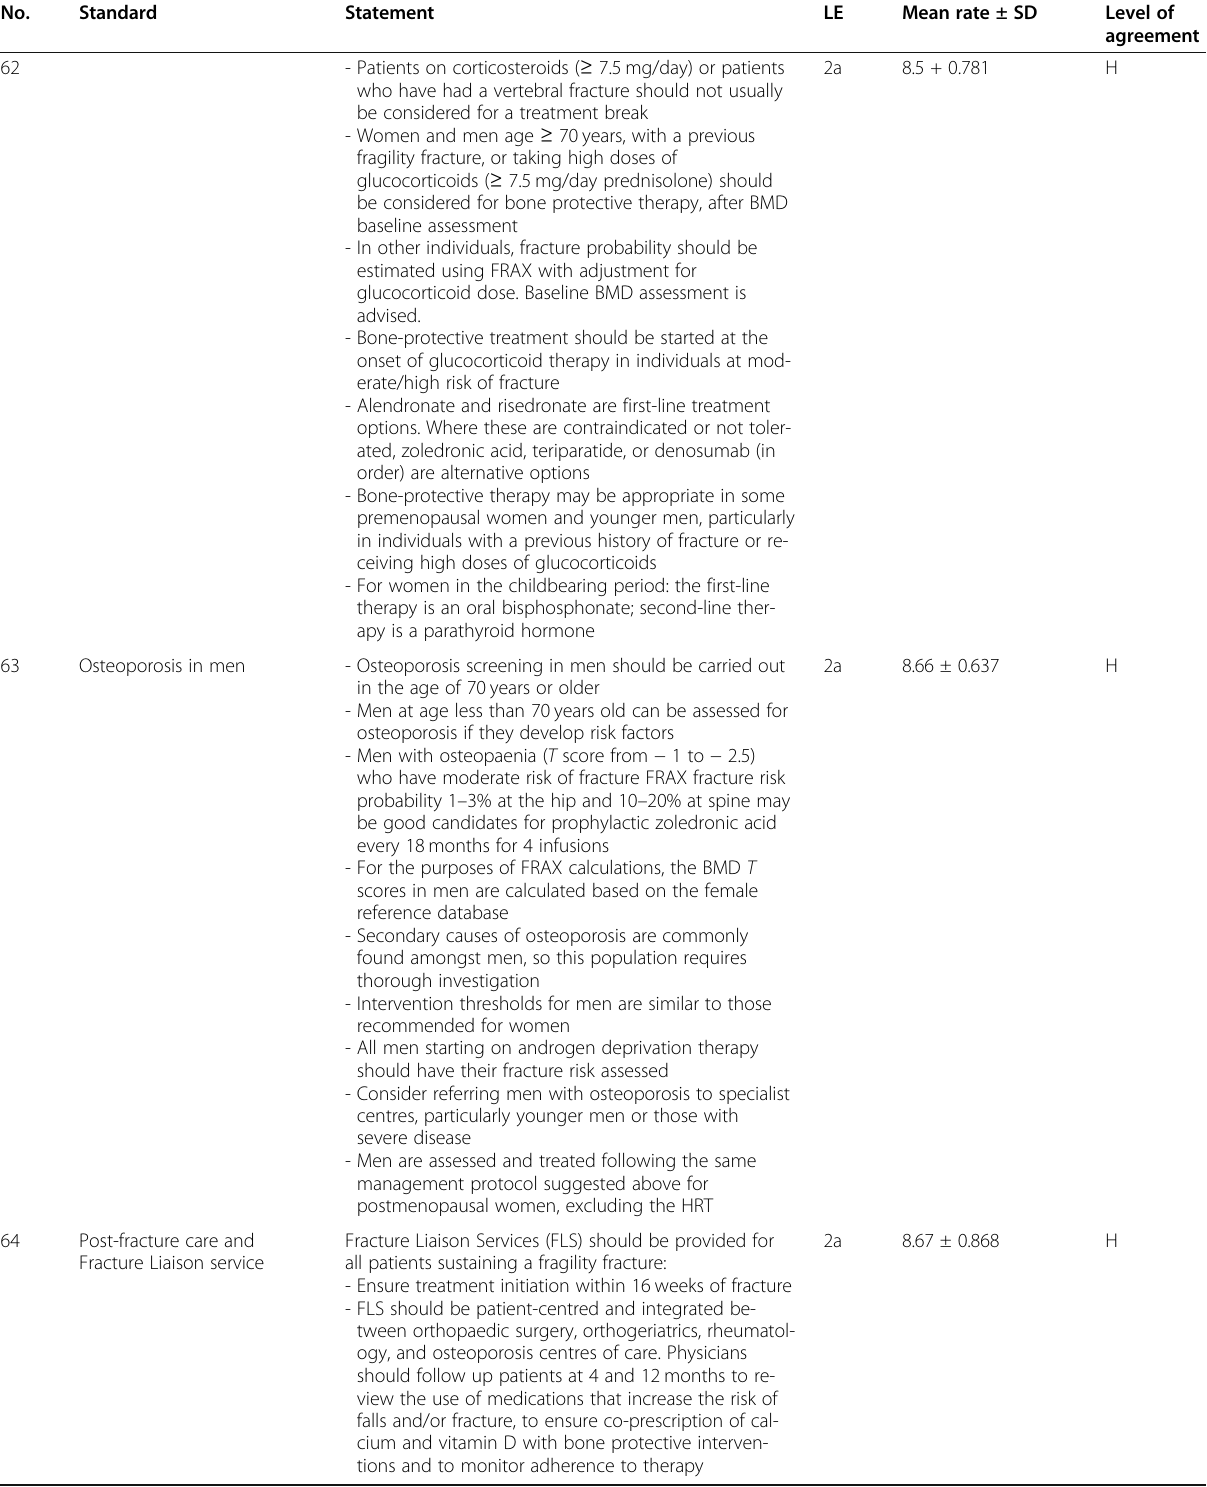
Table 2 Breakdown of statements of recommendations, its individual rank, and level of agreement (Continued)